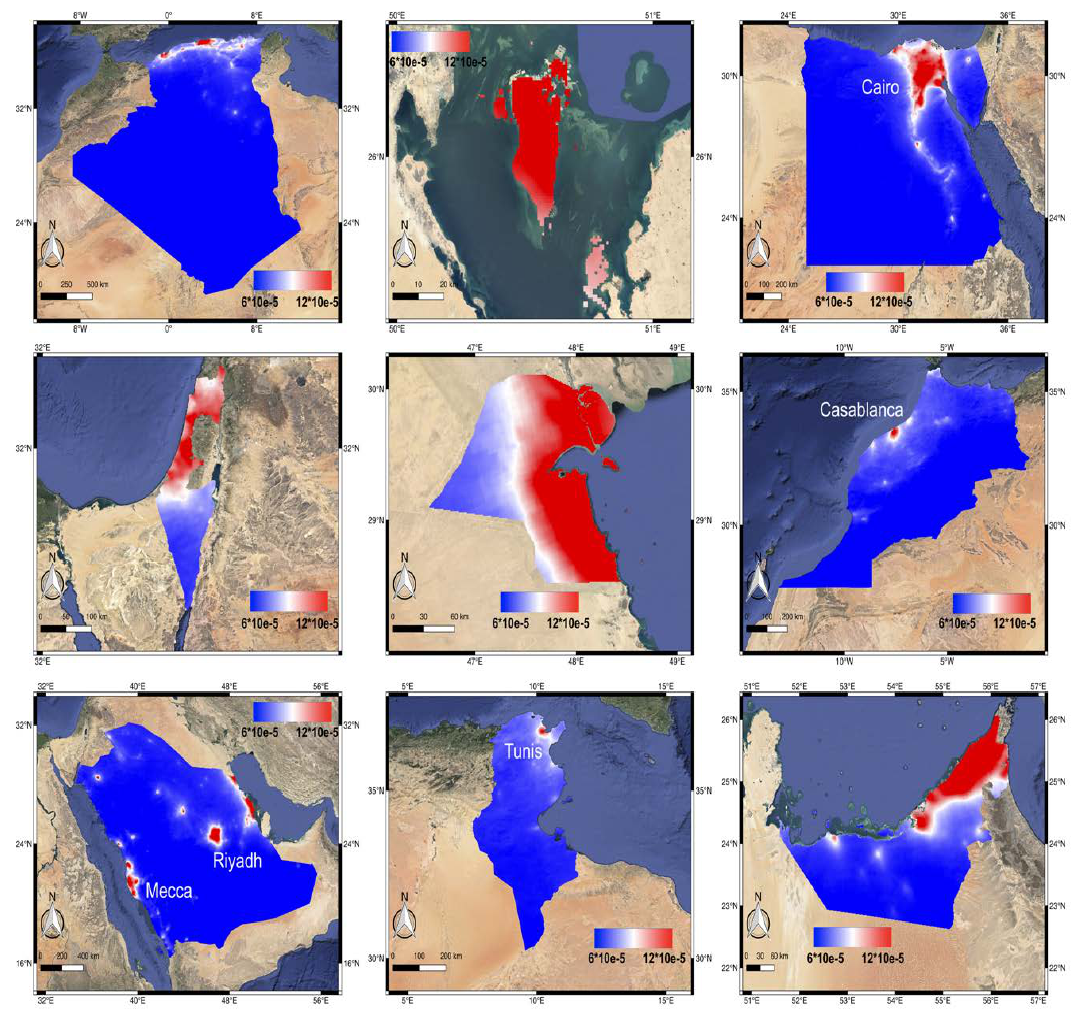
Figure 5. The annually averaged NO2 distribution map of the nine MENA countries (from left to right, top to bottom: Algeria, Bahrain, Egypt, Israel, Kuwait, Morocco, Saudi Arabia, Tunisia, and UAE) from July 11, 2018 till July 10, 2019.